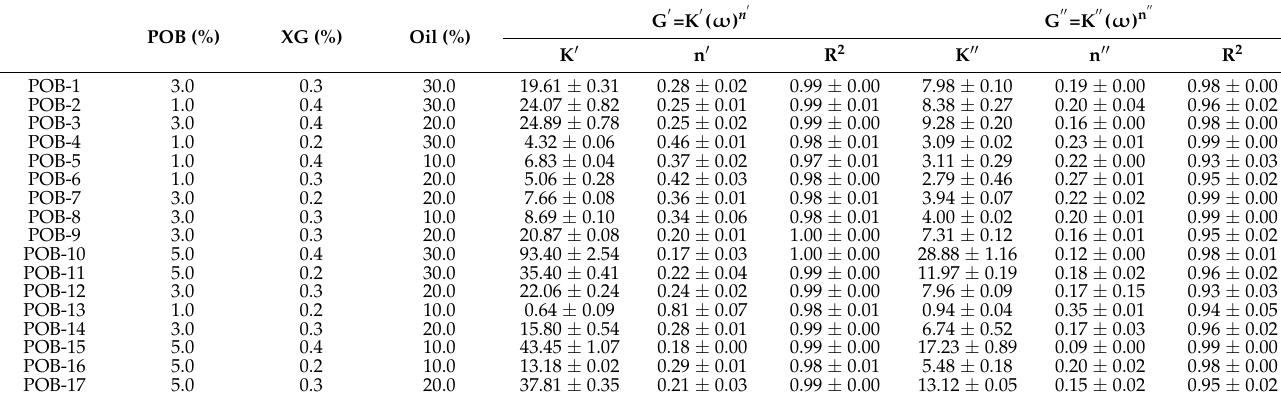
Table 2. Power-law parameters defining dynamic rheological properties of the salad dressing